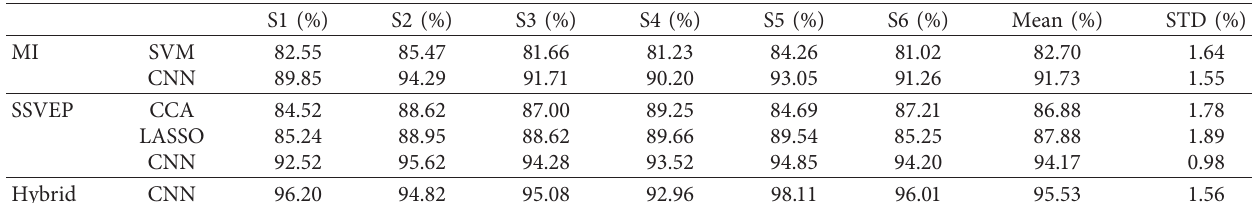
Figure 7: (a) The accuracy comparison between the single frequency feature (5–15 Hz) and the harmonic frequency feature (5–25 Hz) of the six subjects. (b) The accuracy comparison between the single frequency feature (5–15Hz) and the harmonic frequency feature (5–20Hz) of the six Table 1: The accuracy and STD of the same input signals from different classifiers for the six subjects.